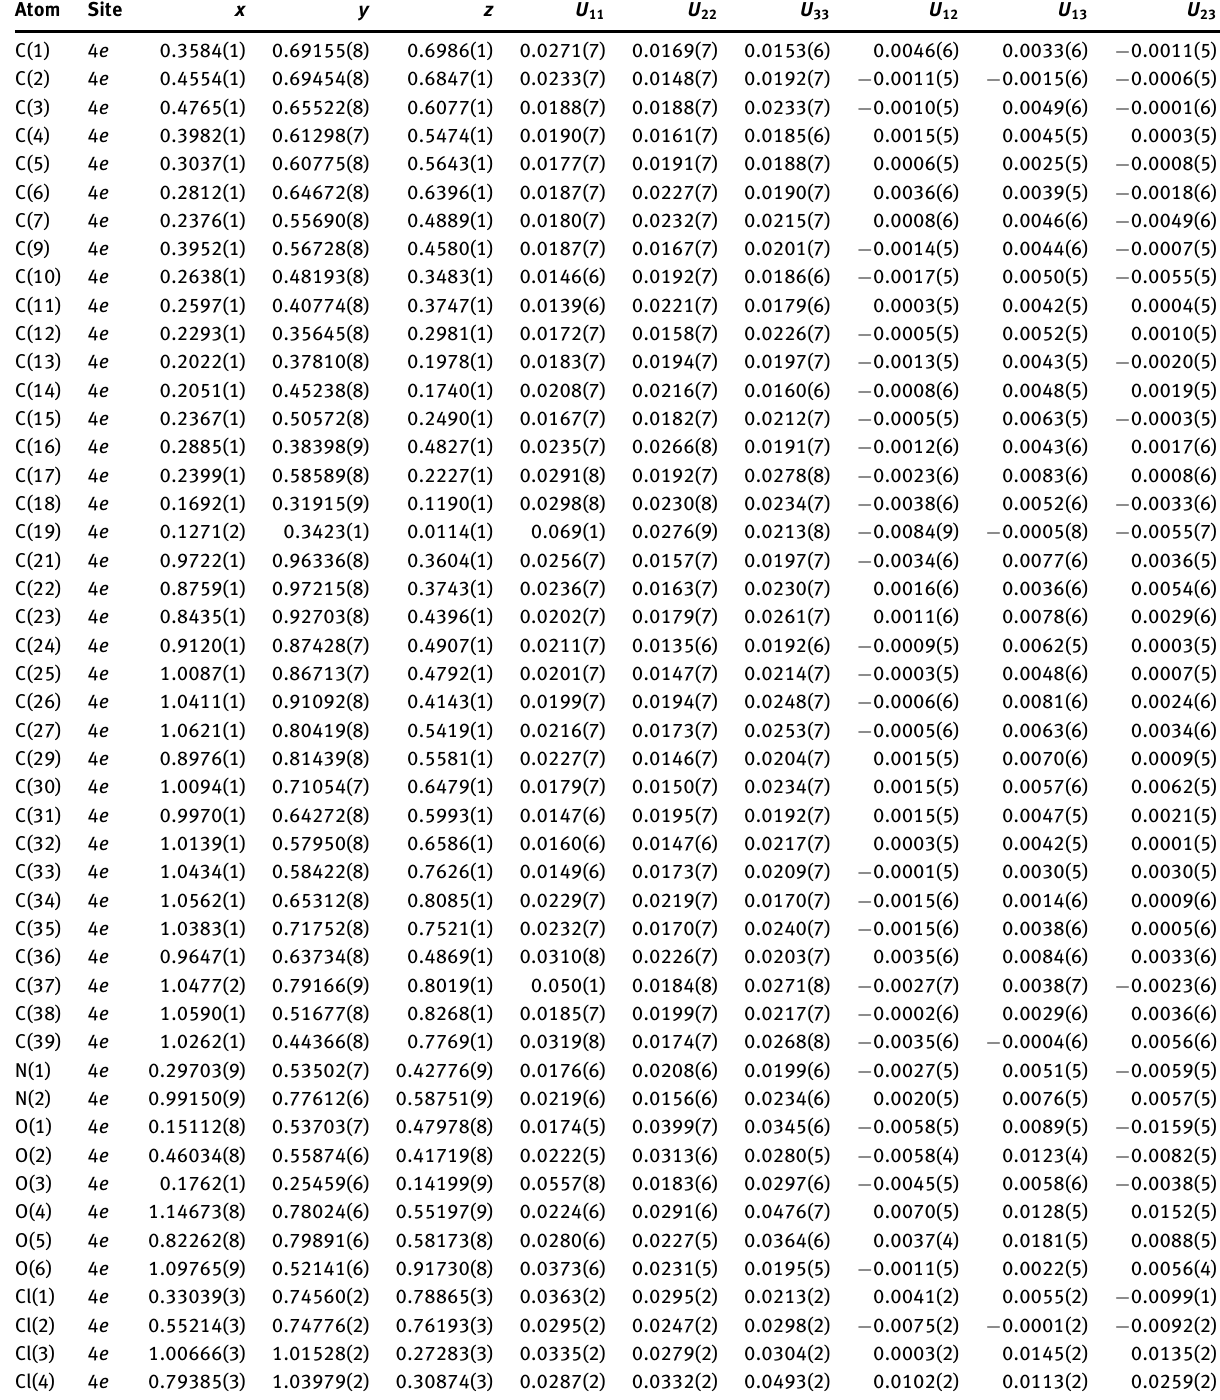
Table 3: Atomic displacement parameters (Å 2